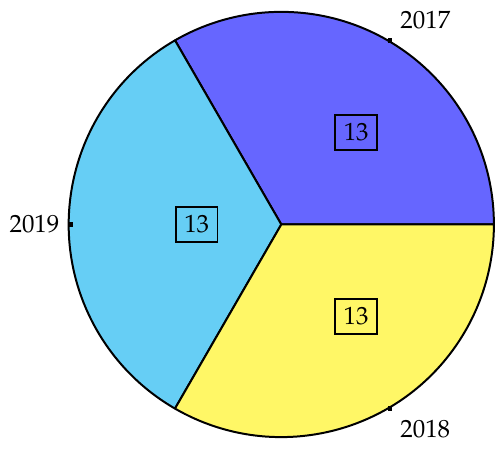
Figure 4. Year-wise categorization of studies on the FOREX market.